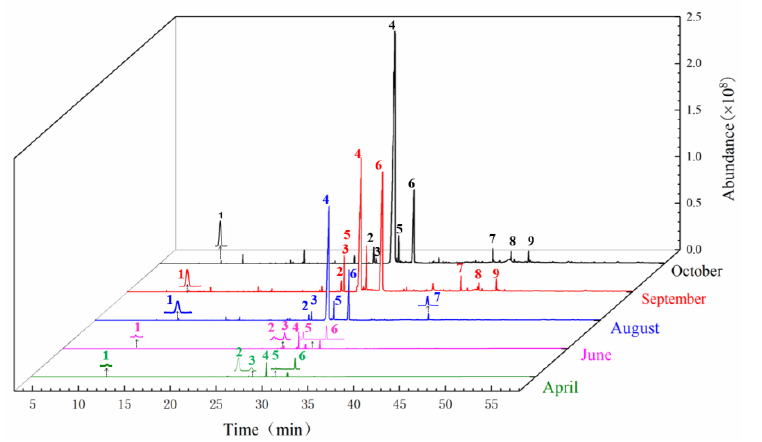
Figure 2. Total ion chromatogram from the head of root of A. sinensis in different periods. Note: 1: α -Pinene; 2: Z-Butylidenephthalide; 3: 3-Butylisobenzofuran-1(3H)-one; 4: (E)-Ligustilide; 5: Senkyunolide A; 6: (Z)- Ligustilide; 7: Panaxynone; 8: γ -Sitosterol; 9: Senkyunolide H. Table 1. Analysis of chemical components in the head of A. sinensis in different periods.